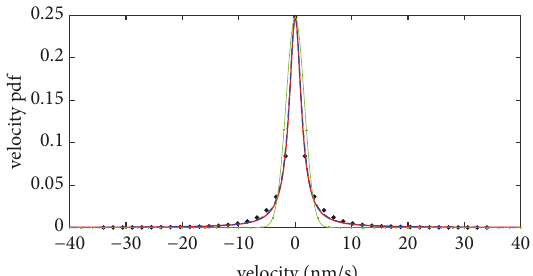
Figure 2: Velocity PDF: the solid line (red) represents the Cauchy-Lorentz distribution, the dashed line (blue) is the truncated Cauchy- Lorentz distribution, the “+” line (green) is the Gaussian distribution, and the black dots are the experimental data, when I=0.1 (tunneling current) and V=0.1 (bias voltage).